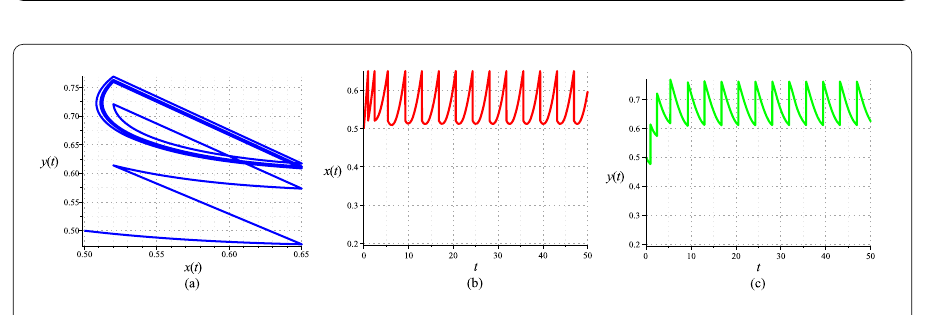
Figure 8 Numerical simulations in Case I. ( a ) Phase portrait of x ( t ) and y ( t ) on h = 0.65. ( b ) Time series of x ( t ). ( c ) Time series of y ( t